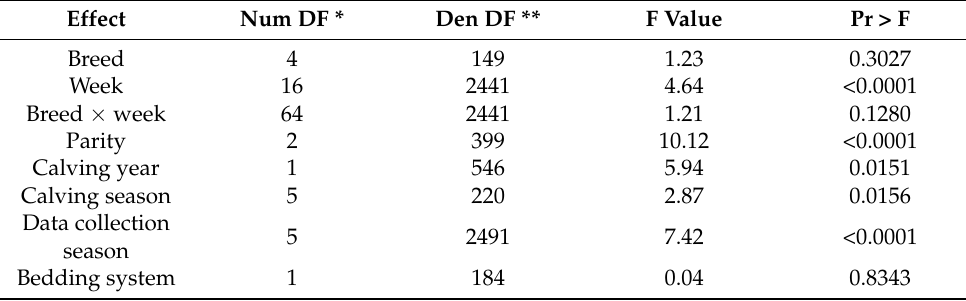
Table A7. Variance analysis results for the variable locomotion score (LS).